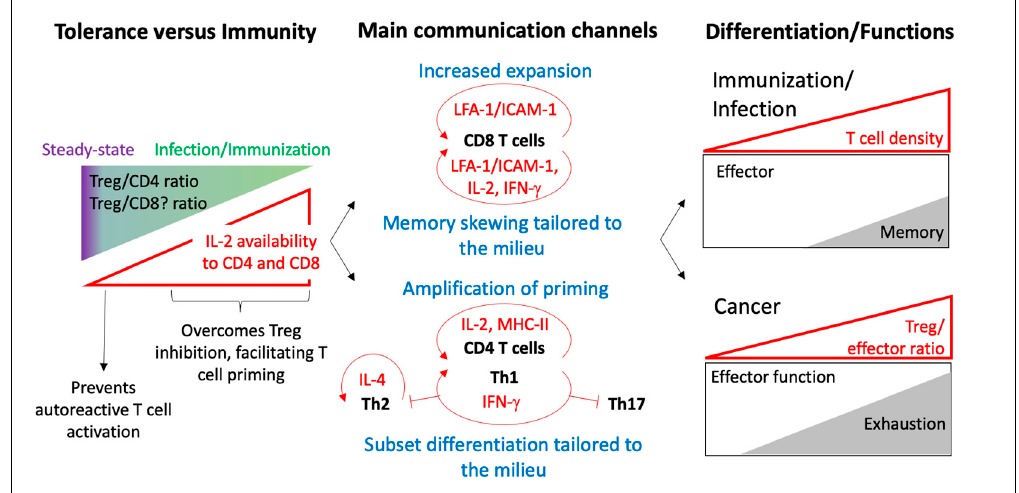
Figure 2. Current knowledge on T-T communication and associated functions. Cartoon summarizes the involvement of T-T communication in the balance between tolerance and immunity, the main communication mechanisms they use and the consequences during Infection and Cancer. Features of T cell communication are shown in red, and the outcome of T cell communication is shown in blue. At steady state, auto-reactive T cells are kept at bay, because of a high Treg / T cell ratio. Following infection, this ratio decreases, resulting in T cell priming through increased IL-2 availability ( left panel ). Following activation, T cells use a variety of communication channels to regulate their expansion and di ff erentiation required and according to the injury ( middle panel ). This results in a robust population response following infection, fine-tuned by T cell density. T cell communication can be co-opted in cancer, promoting T cell exhaustion ( right panel ).